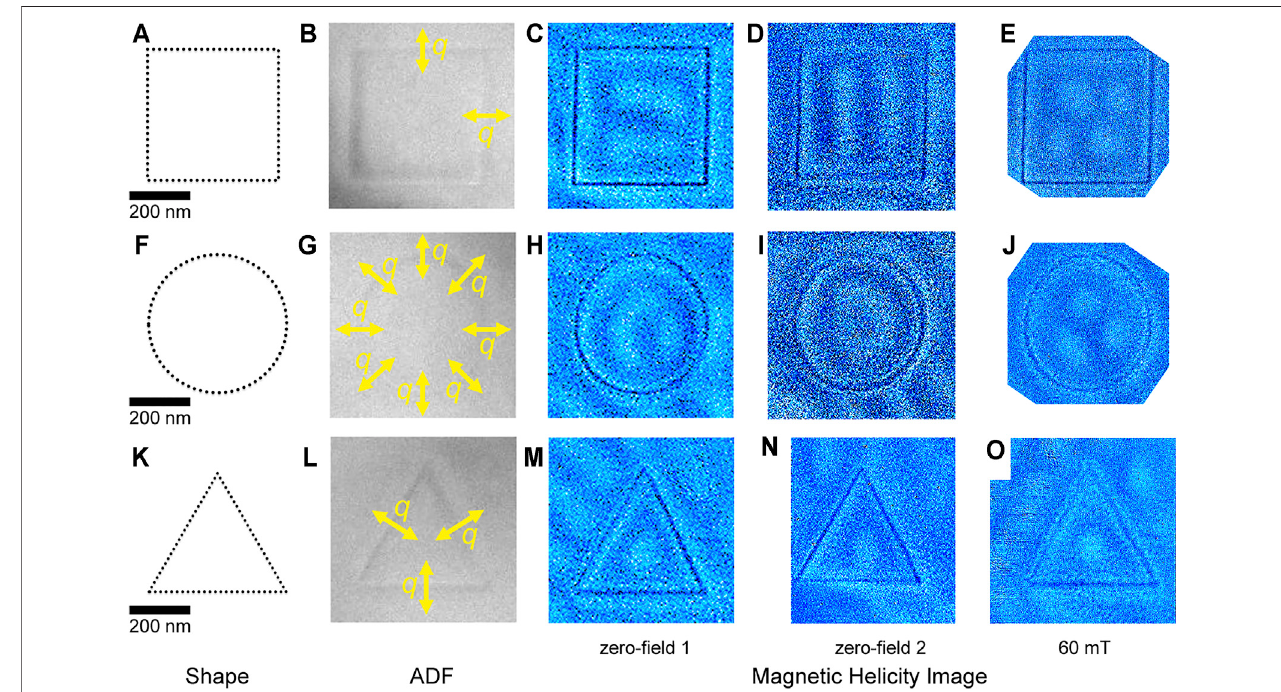
FIGURE2| Skyrmionstatescon fi nedtosurface-pitcorralswiththreesimplegeometries.Schematicsof (A) asquare, (F) acircle,and (K) atriangularcorral.Annular dark- fi eld images of fabricated corrals with a square (B) , a circle (G) , and a triangle geometry (L) by using a focused electron beam. The edge length of the square, diameter of the circle, and edge length of the equilateral triangle are equally 440 nm. Several q-vectors de fi ned by each corral are indicated by yellow arrows in (B) , (G) , and (L) , respectively. Magnetic helicity images of spin textures con fi ned to a square corral (C – E) , a circular corral (H – J) , and a triangular corral (M – O) are shown. Spin textures in two independent zero- fi eld conditions (C , D , H , I , M , N) and under the perpendicular magnetic fi eld of 60 mT (E , J , O) are shown. Skyrmions are displayed as bright particles. Pixel dwell time is 1